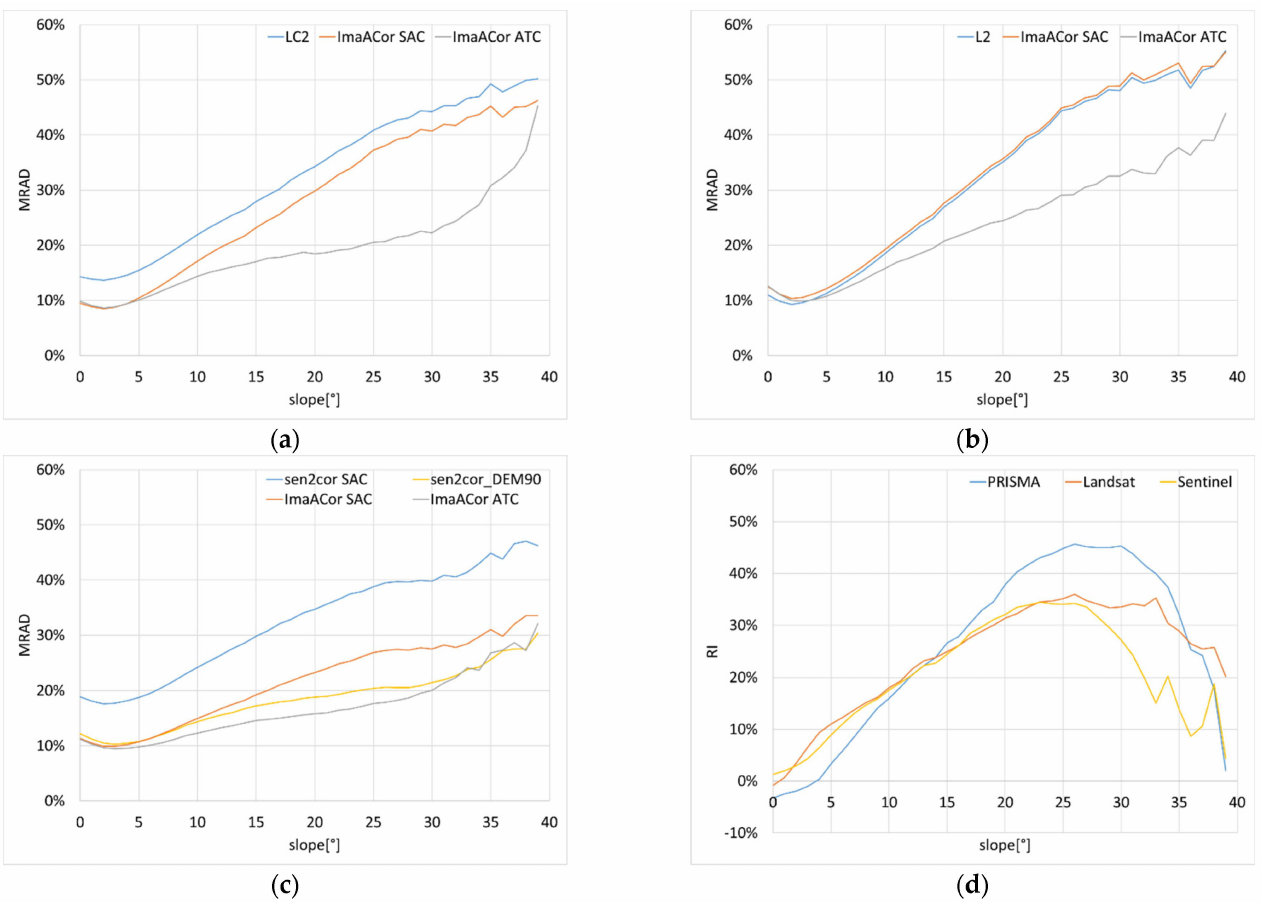
Figure 9. ( a ) MRAD plots, as a function of slope, of ImaACor reflectances obtained from L1C PRISMA data by applying SAC and ATC; ( b ) MRAD plots, as a function of slope, of ImaACor reflectances obtained from L1C2 Landsat − 8 data by applying SAC and ATC; ( c ) MRAD plots, as a function of slope, of sen2cor and ImaACor reflectances obtained from L1 Sentinel − 2 data applying SAC and ATC; ( d ) ImaACor RI plots, as a function of slope, relating to PRISMA, Landsat − 8 and Sentinel − 2